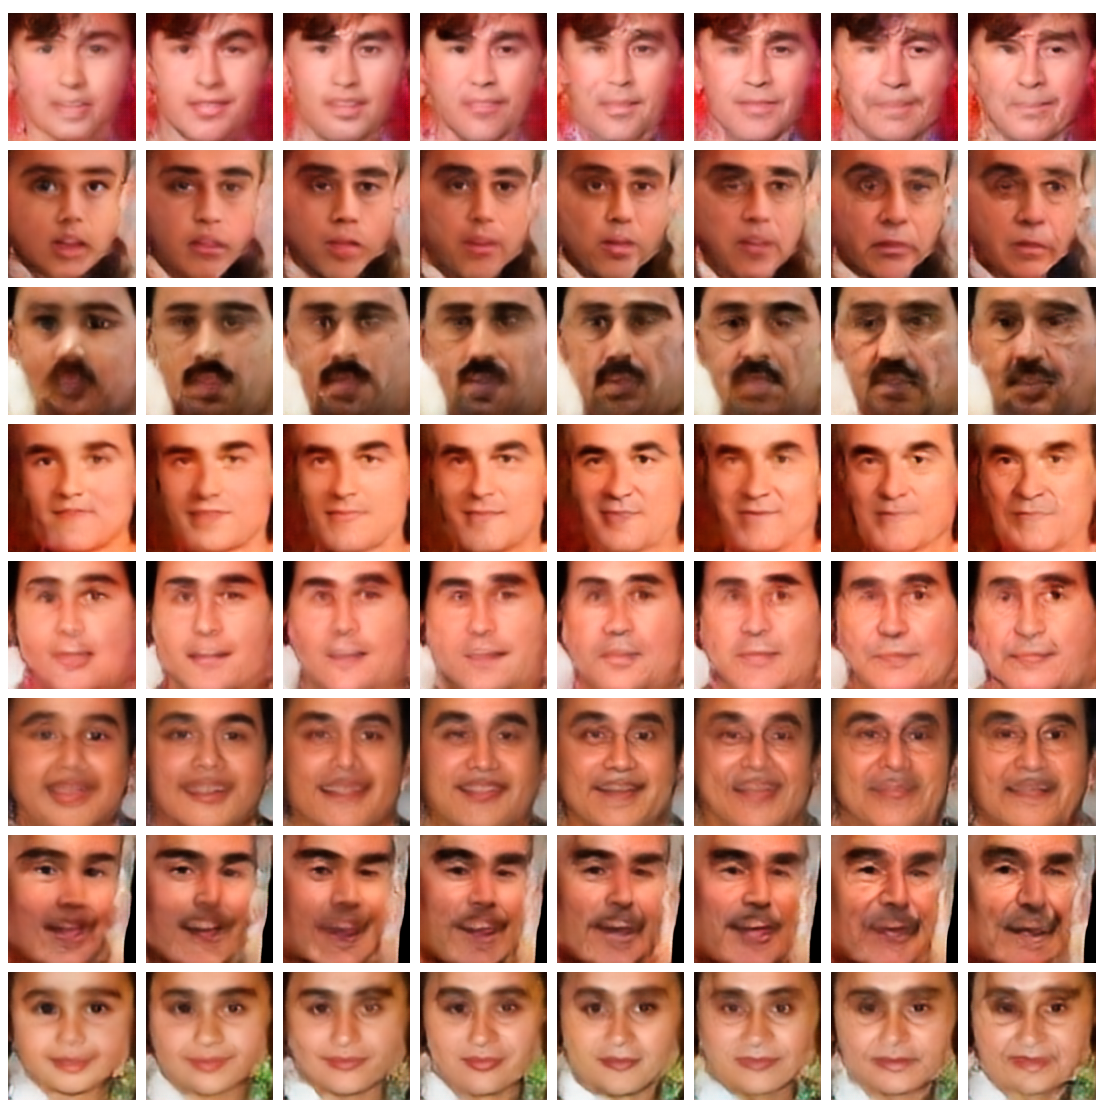
Figure 8. Some errors or fails produced by the network.